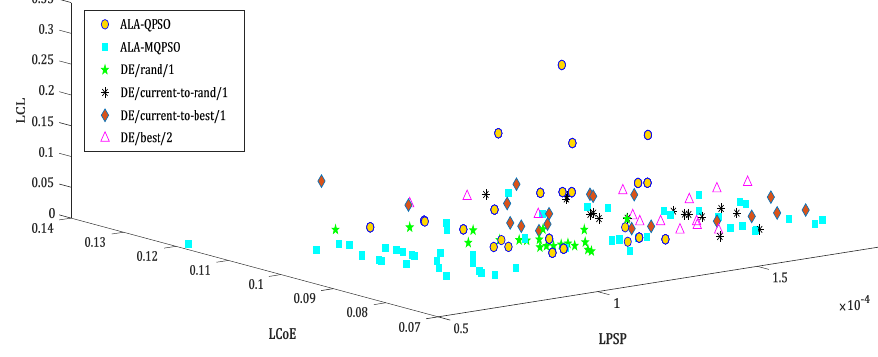
Figure 12. Pareto fronts of proposed techniques.